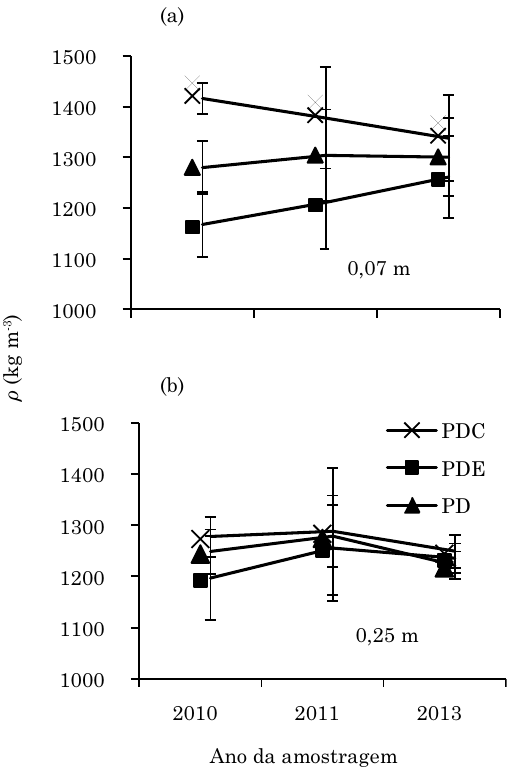
Figura 5. Densidade do solo ao longo do tempo após compactação (PDC), em 2010 (três tráfegos de trator) e 2011 (um tráfego de trator); e escarificação (PDE), em 2010, comparados ao solo em plantio direto (PD), nas profundidades de 0,07 e 0,25 m. Barras verticais representam o